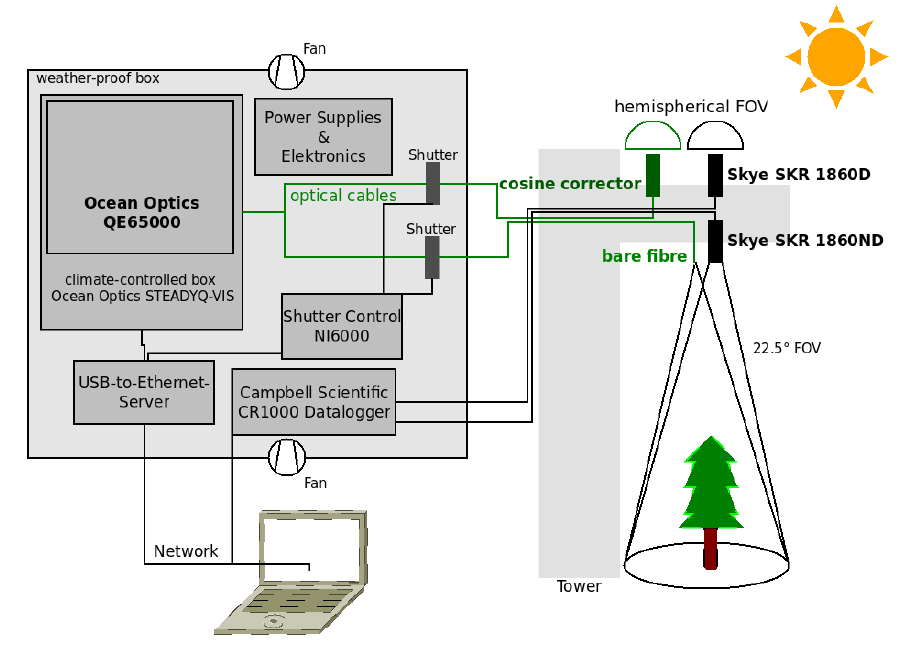
Figure 2. Schematic overview of sensor setup for unattended hyperspectral and multispectral measurements. Electronics and the hyperspectral sensor are installed in a weather-proof box and connected to the network. Fore optics and multispectral sensors are mounted on a boom of a tower above the